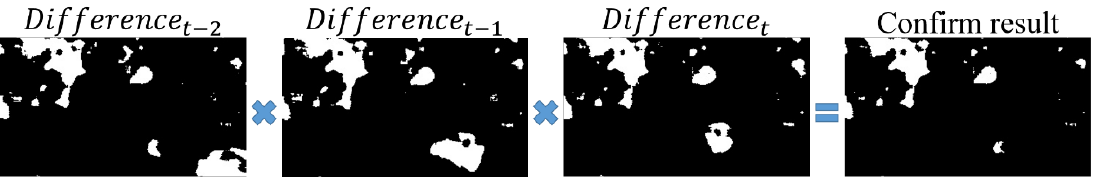
Figure 7. Concept of the confirmation strategy.